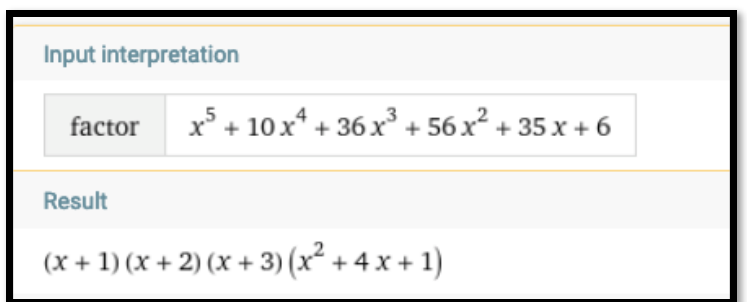
Figure 3. Factoring a Fibonacci-like polynomial.